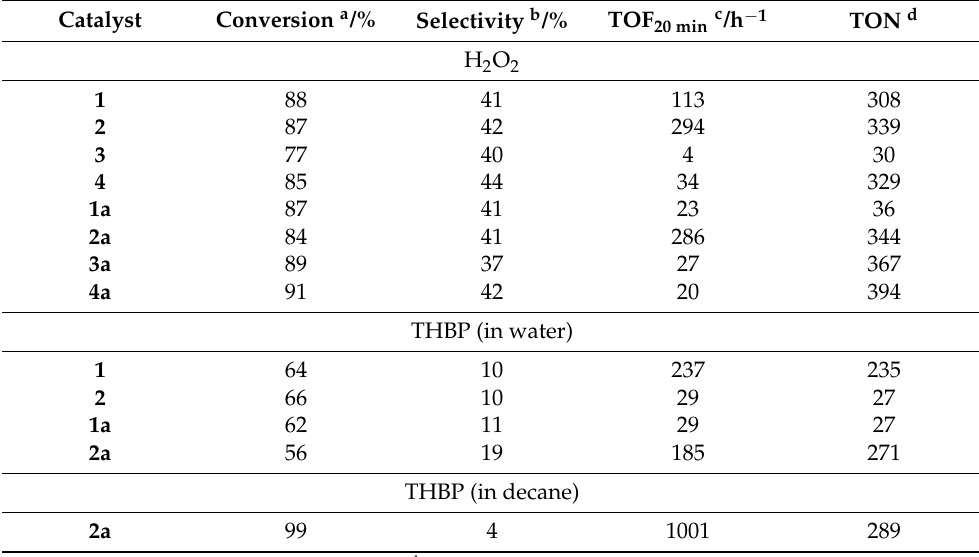
Table 2. Results of the carveol oxidation catalysed with molybdenum(VI) complexes under following conditions n (Mo): n (substrate): n (oxidant) = 1:400:800, T = 353 K.